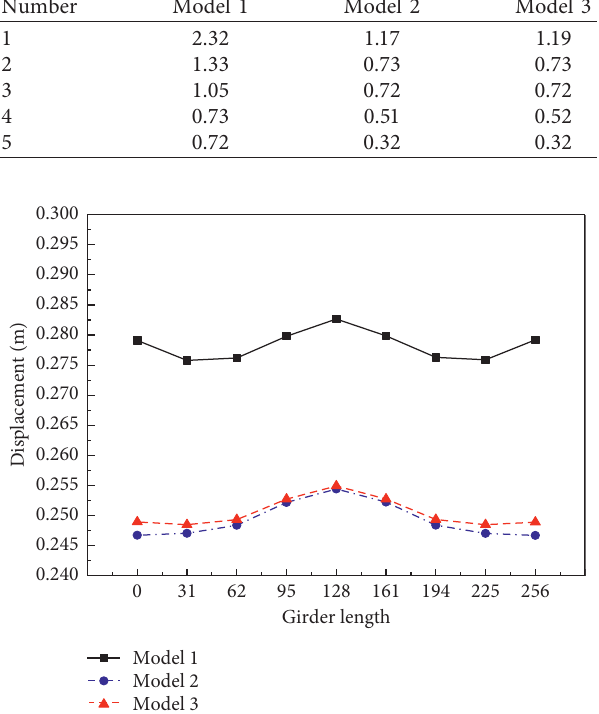
Figure 7: The peak displacement of key position of the girder.